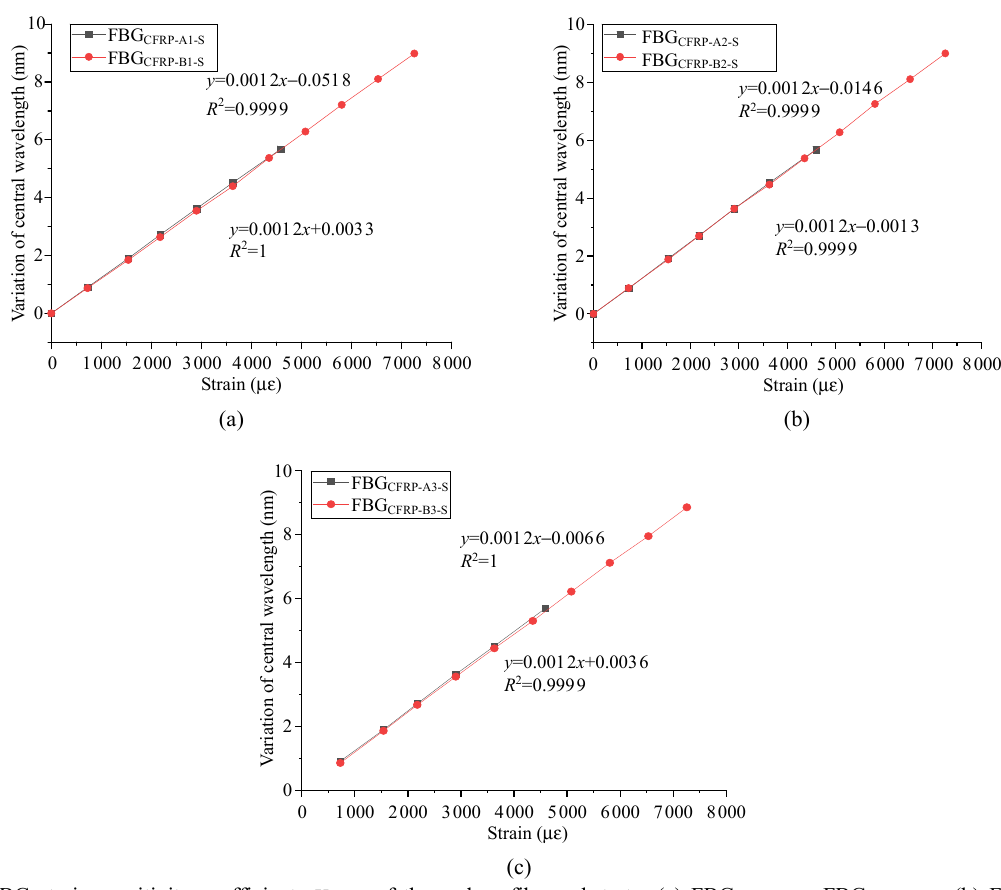
of the carbon fiber substrate: (a) FBG CFRP-A1-S , FBG CFRP-B1-S , (b) FBG CFRP-A2-S , K ε− M